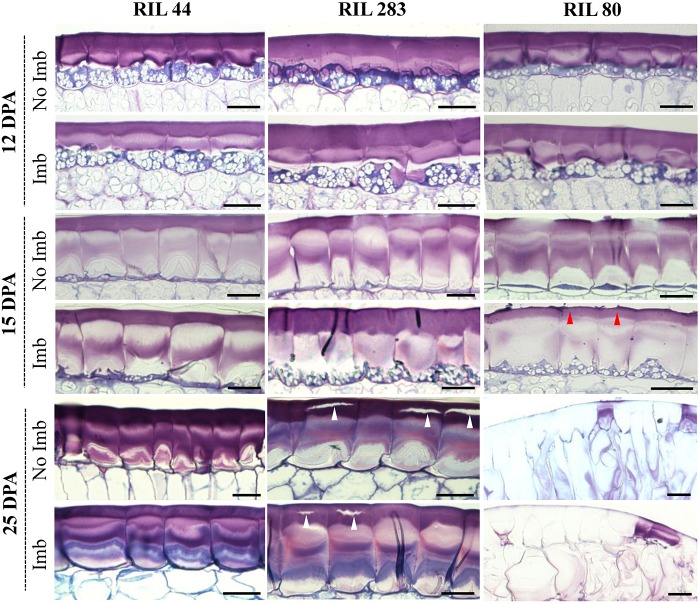
MSCs of RIL 80 are more sensitive to water imbibition relative to RIL 44 and 283. Structural and developmental analysis of seed coat MSCs from RILs 44, 283, and 80. Each image represent toluidine blue O-stained sections through the seed coat of intact seeds harvested at 12 DPA, 15 DPA, and 25 DPA. The time lapse of significant mucilage release is faster in RIL 80 compared to RIL 44 and 283 (red arrow), and in RIL 283 compared to RIL 44 (white arrow). For each developmental stage, seeds were analyzed before and 24 h after imbibition. Imb, imbibed; No Imb, non-imbibed. Bars = 40 μm.